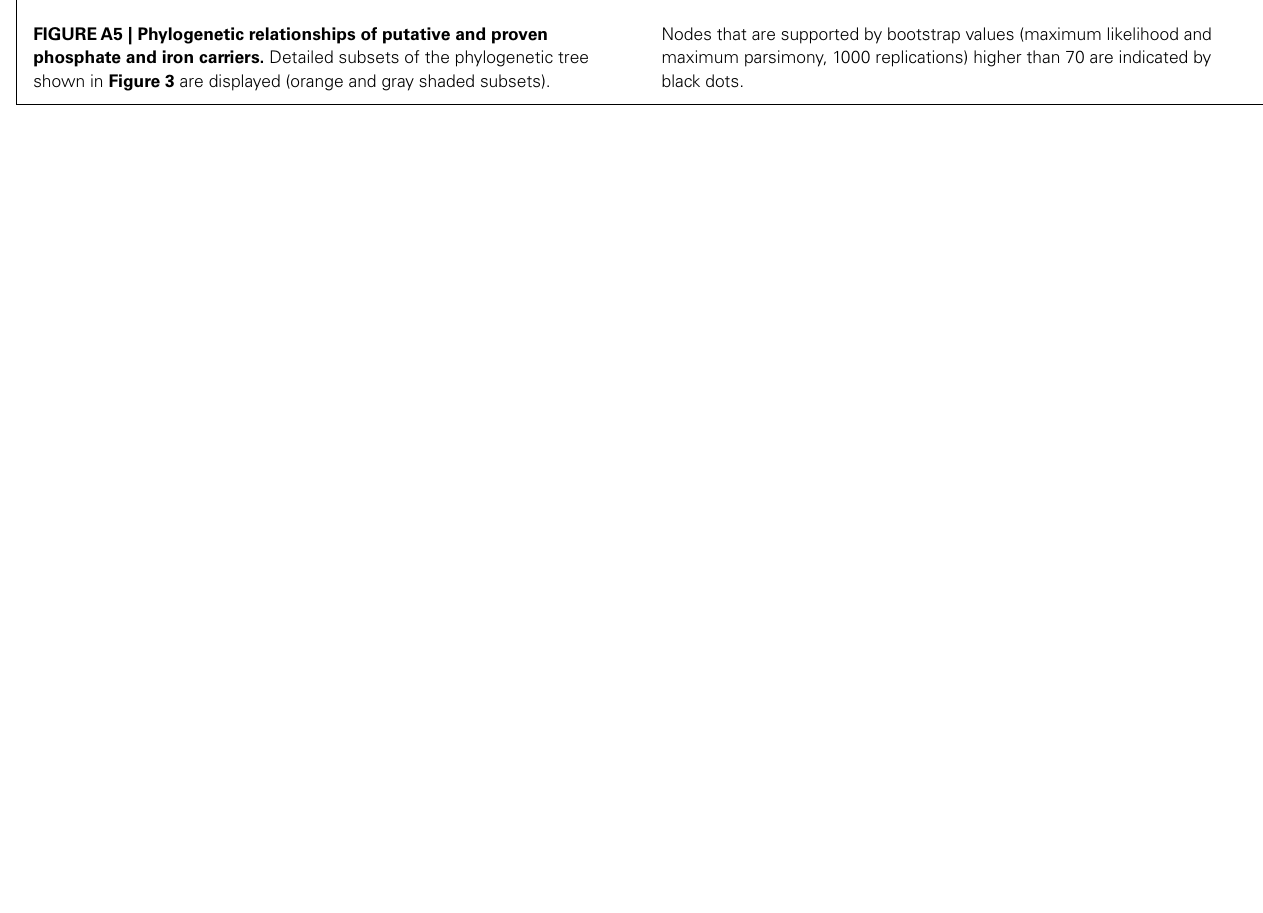
FIGUREA5 | Phylogenetic relationships of putative and proven phosphate and iron carriers. Detailed subsets of the phylogenetic tree shown in Figure 3 are displayed (orange and gray shaded subsets).